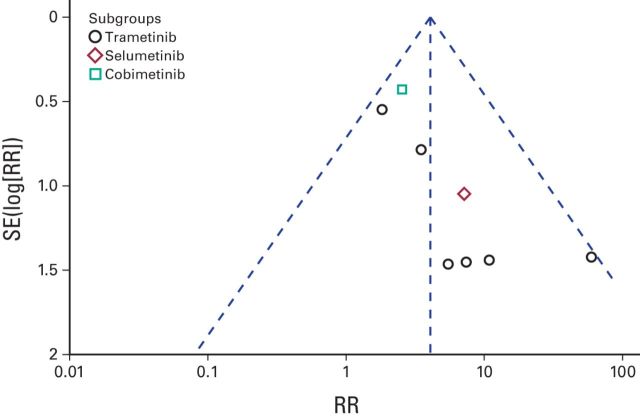
Funnel plot for publication bias for decreased ejection fraction. RR, risk ratio.